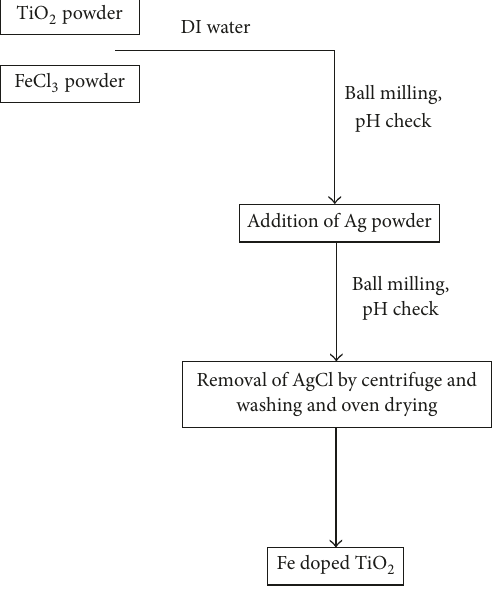
Figure 2: Flow chart for preparing Fe doped TiO 2 .